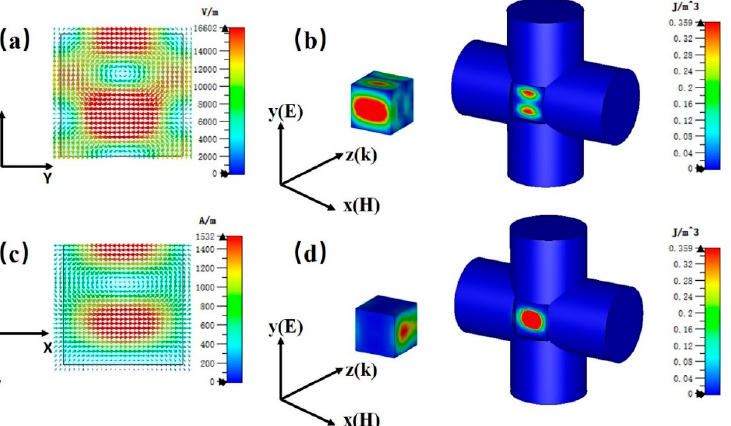
Figure 4. Simulated results of the distribution and energy density of electric field and magnetic field at 9.82 GHz: ( a ) E-field distribution; ( b ) E-field energy density; ( c ) M-field distribution; and ( d ) M-field energy density.